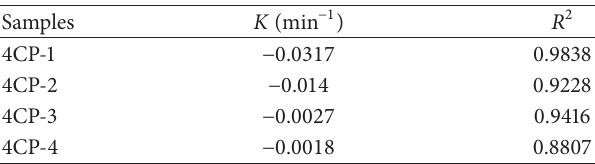
Table 1: Kinetics parameters for 4CP degradation based on the pseudo-first-order